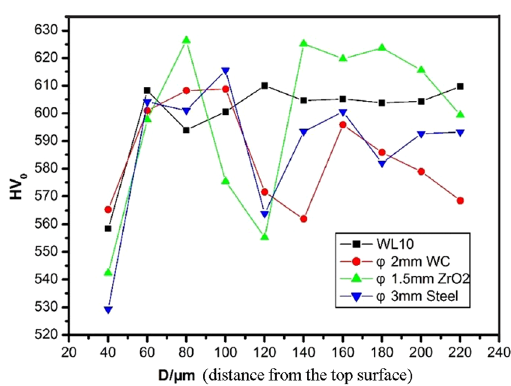
Figure 4. Microhardness of different samples taken from the cross-sectional plane in the depth direction. “D” references the distance beneath the top